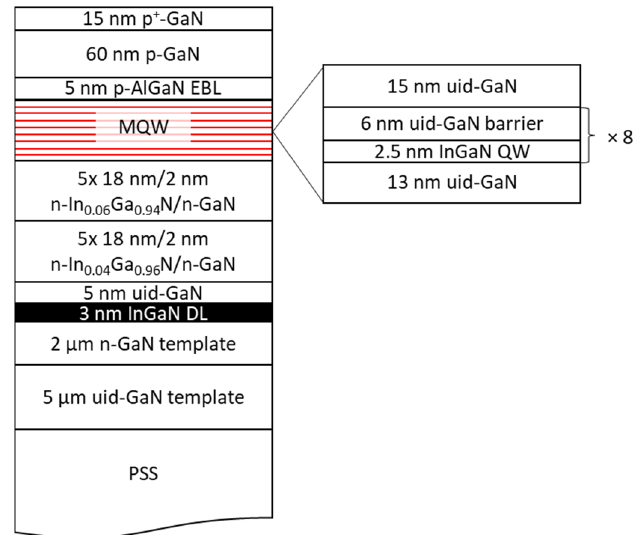
Figure 1. Schematic of the LED epitaxial